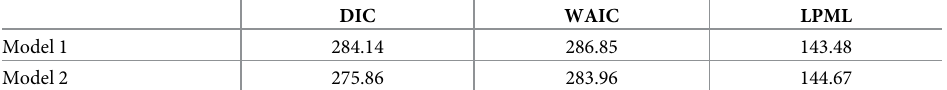
Table 4. Evaluation of Bayesian Hierarchical Spatiotemporal model without covariates (model 1) and Bayesian Hierarchical Spatiotemporal model with covariates (model